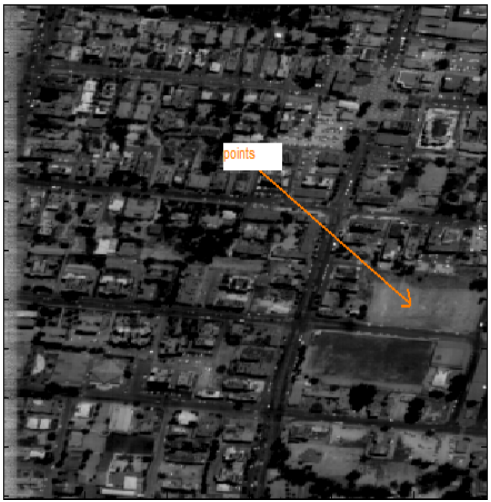
Figure 1. Exemplary points that were taken from the area pointed by the arrow (full image is given in 2nd figure in Section 2.1).